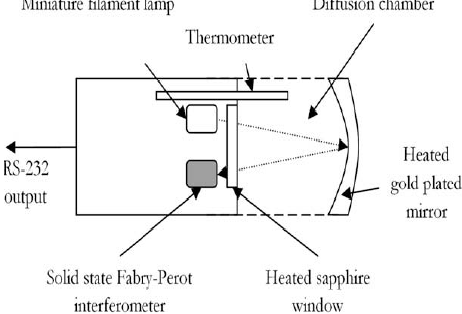
Figure.1 Vaisala CARBOCAP schematic.